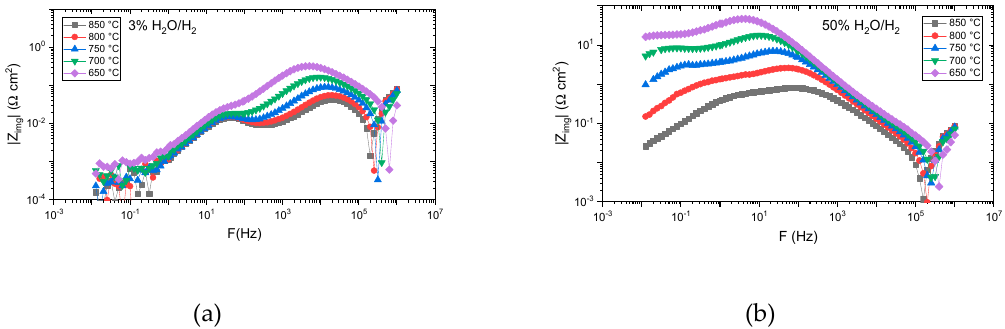
Figure 4. Electrochemical impedance spectroscopy (EIS) data Nyquist plot from Ni-CGO-, Co- and Fe-infiltrated LSCTZ5 at 750 °C in ( a ) 3% H 2 O/H 2 and ( b ) 50% H 2 O/H 2 ; the high frequency intercept is magnified in a separate ( c ) bar graph plot for comparison with R p values given in Ω cm 2 .